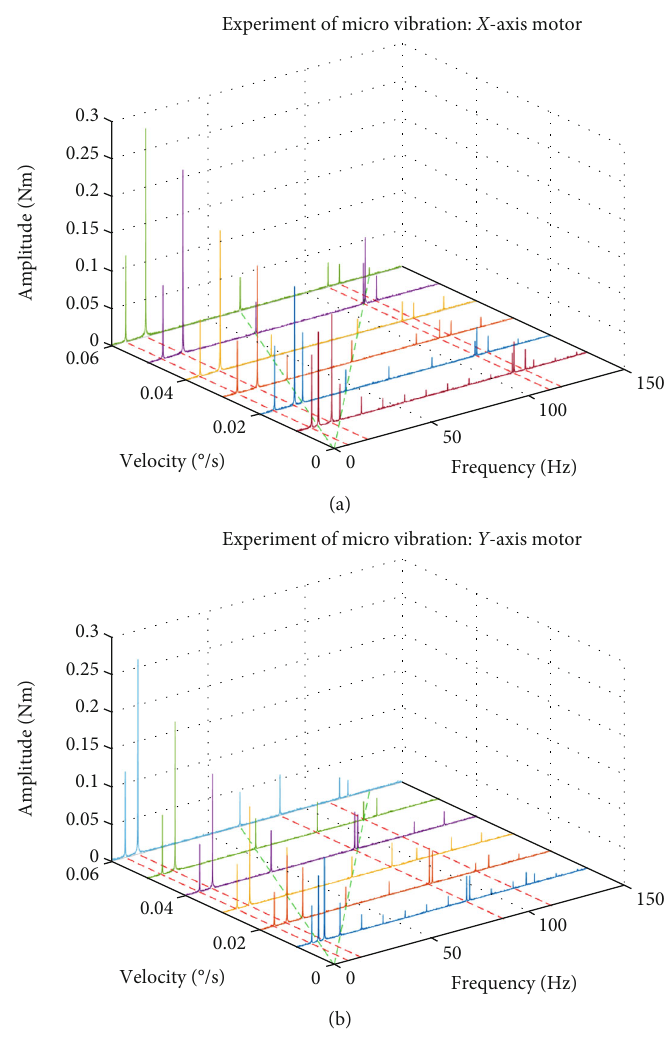
Figure 8: Experimental results of microvibration of the antenna at di ff erent velocity: (a) x -axis motor; (b) y -axis